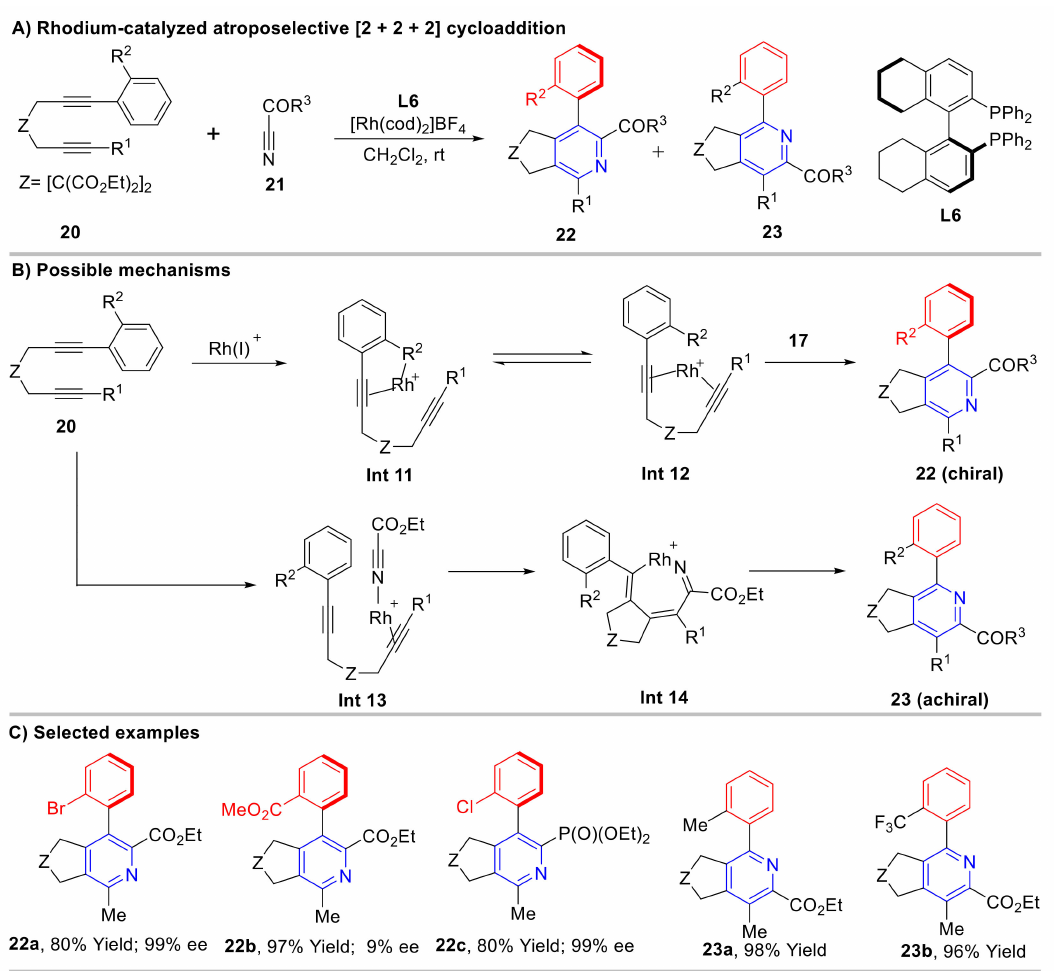
Scheme 6. Rhodium-catalyzed atroposelective [2 + 2 + 2]